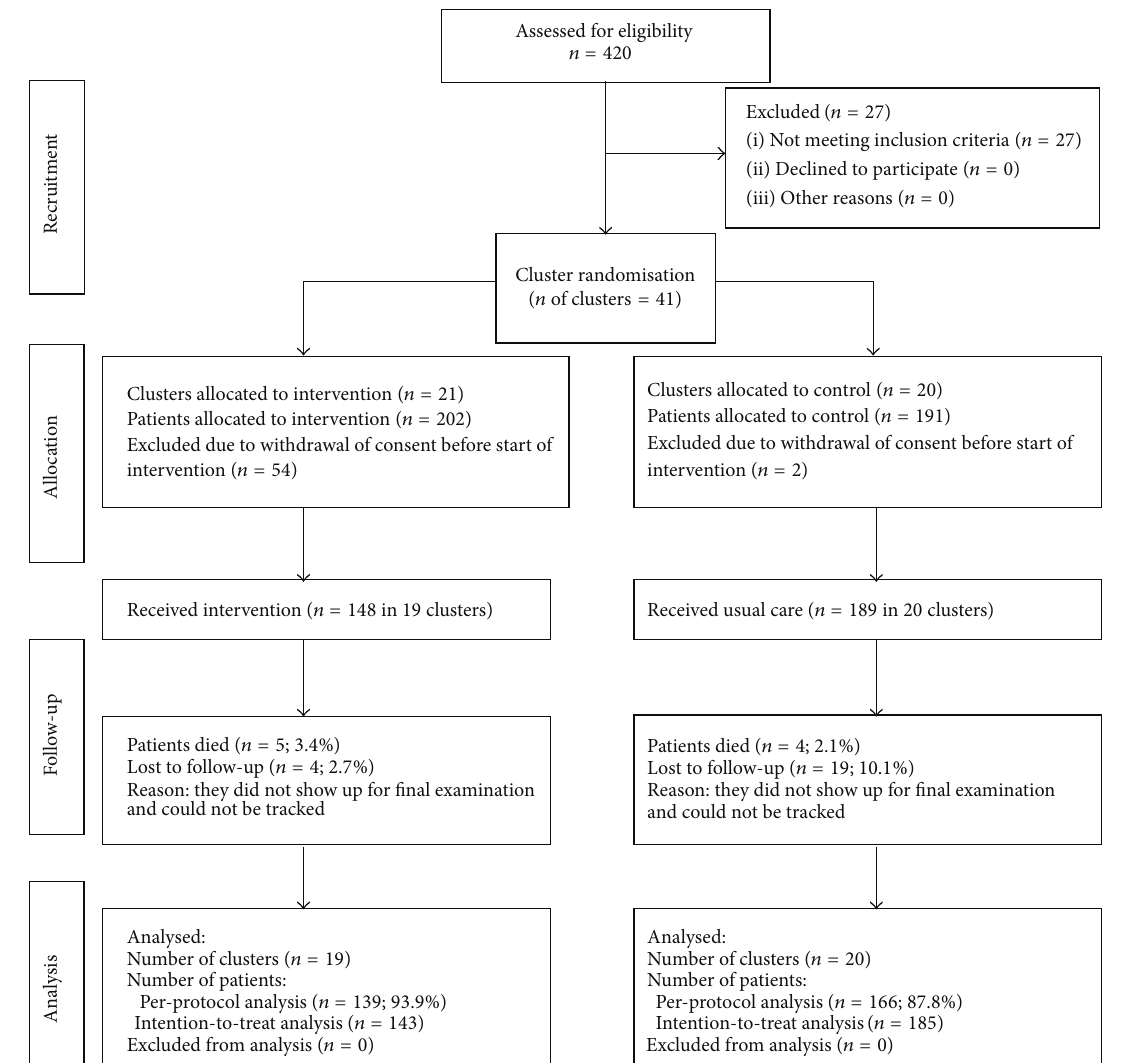
Figure 1: CONSORT diagram for recruitment and follow-up of clusters and